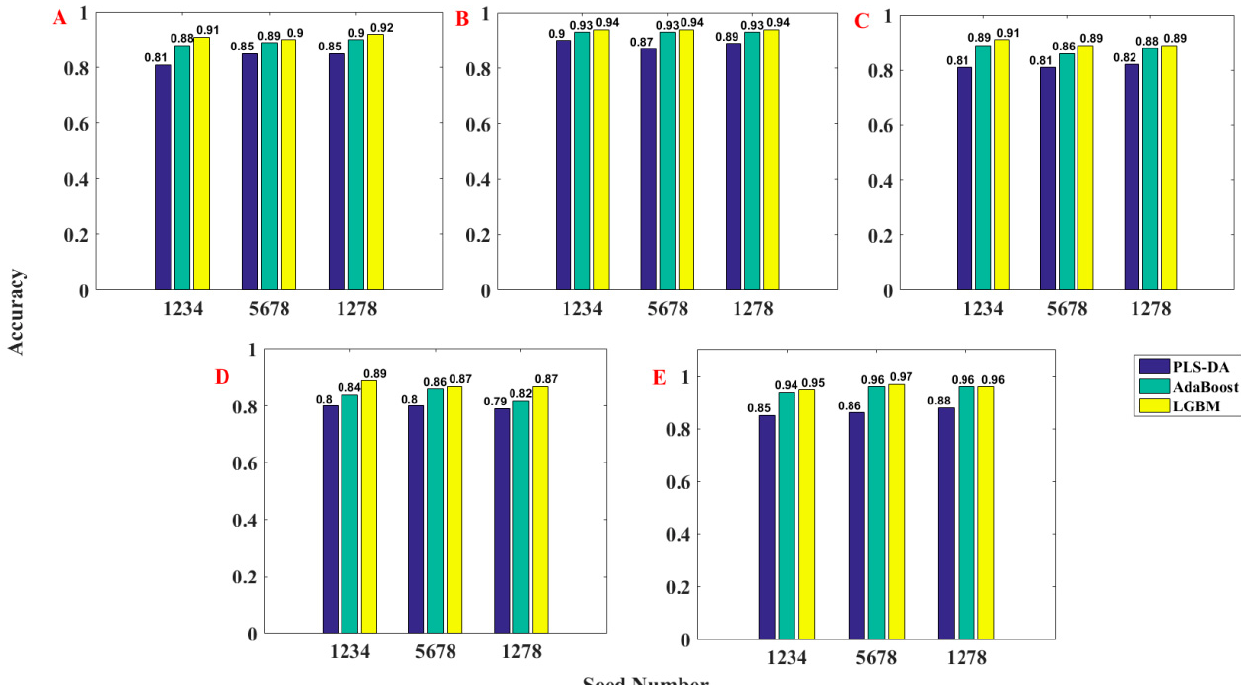
Figure 2. Accuracy histogram of the three models established using PLS-DA, AdaBoost, and LGBM method for Caco-2 ( A ), CYP3A4 ( B ), hERG ( C ), HOB ( D ), and MN ( E ).